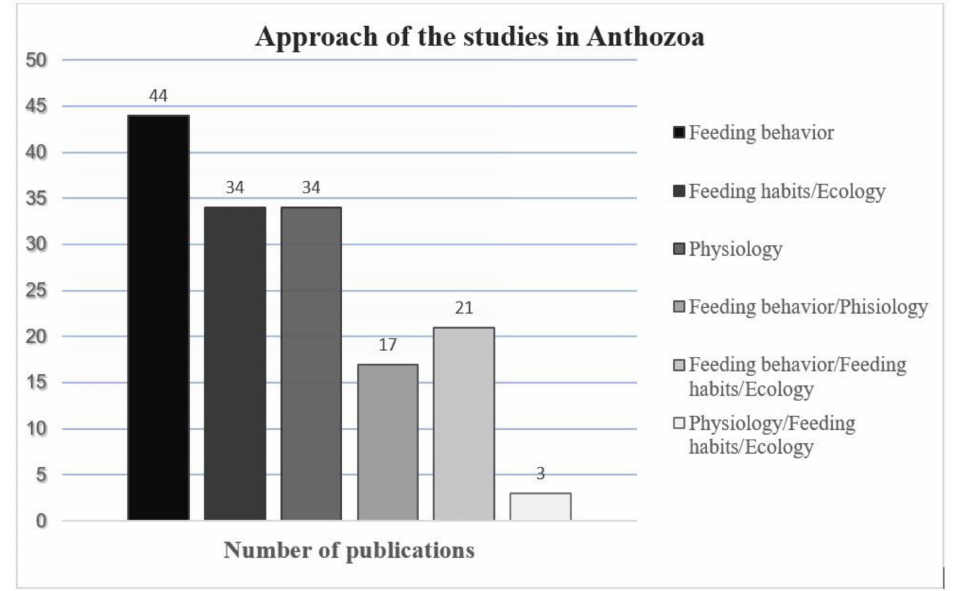
Figure 1. The number of published articles on each approach category in studies of feeding topics in